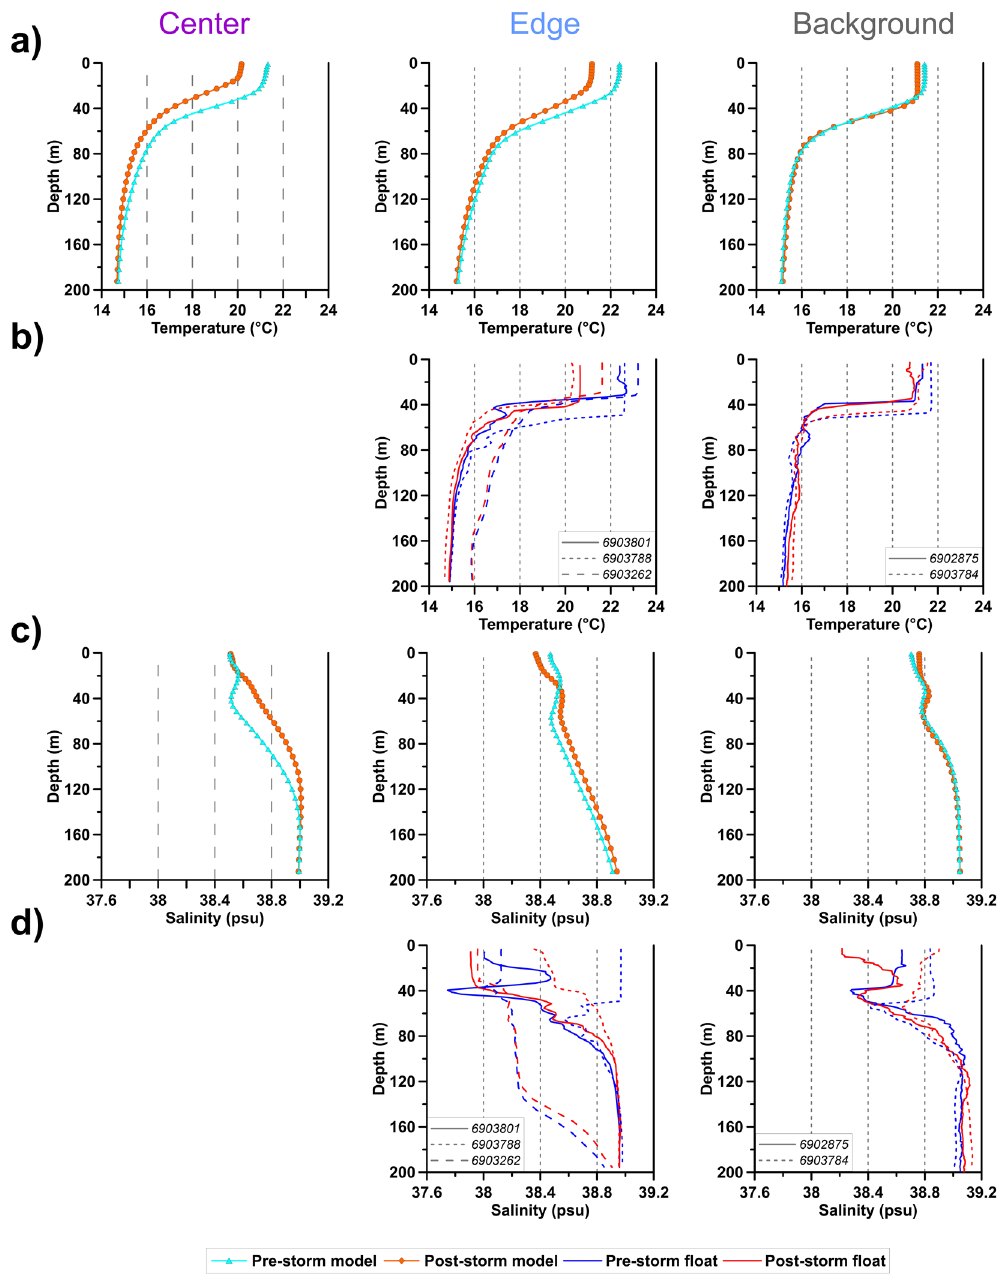
Figure 5. Mean temperature ( a , b ) and salinity ( c , d ) profiles derived from the physical CM model and from Argo floats for the Pre-storm and Post-storm conditions, in the Center (first column), Edge (central column) and Background (right column) sectors. The identification numbers of the Argo floats used are listed in the legend of the corresponding